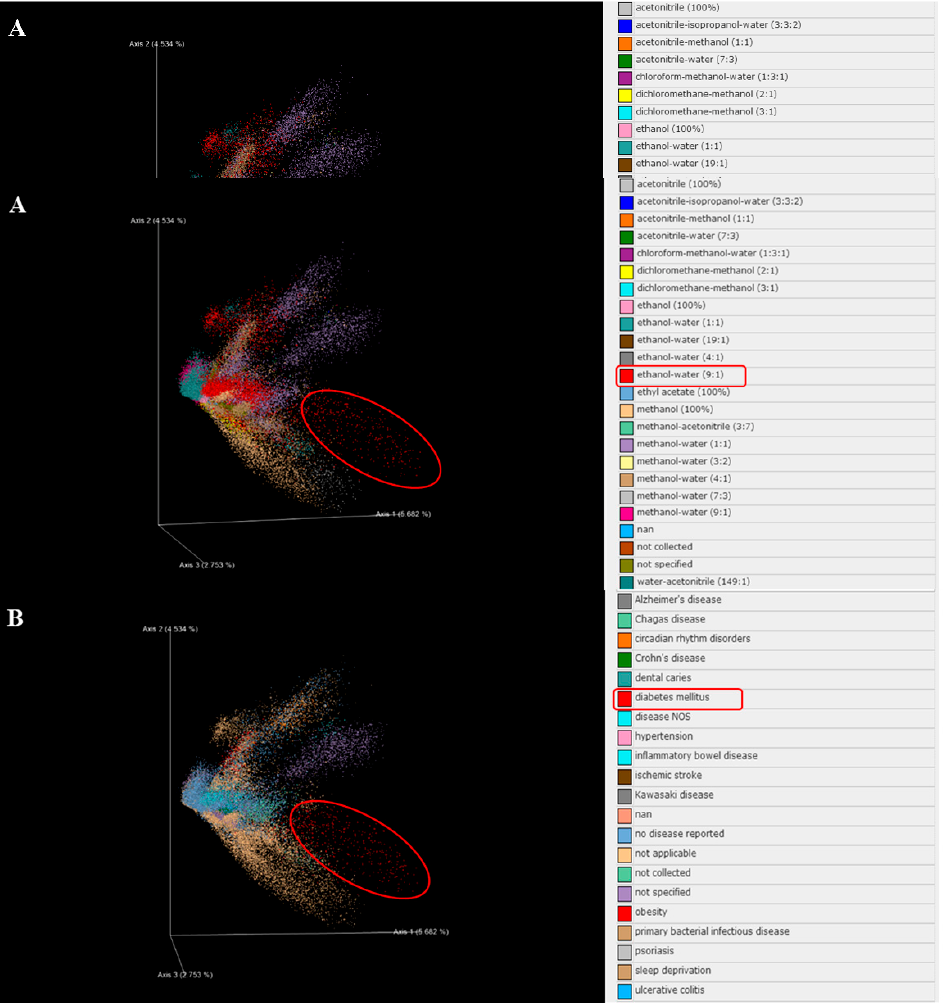
Figure 6. CPF (flavonoids fraction from C. paliurus leaves) ion fragments were collected from diverse solvent sources and showed potential anti-diabetic effects using bioinformatics prediction. ( A ) LC–MS 2 (liquid chromatography–mass spectrometry) to GNPS (Global Natural Product Social Molecular Networking) and Emperor analysis results show diverse solvent sources. ( B ) LC–MS 2 to GNPS and Emperor analysis results show potential anti-diabetic effect.